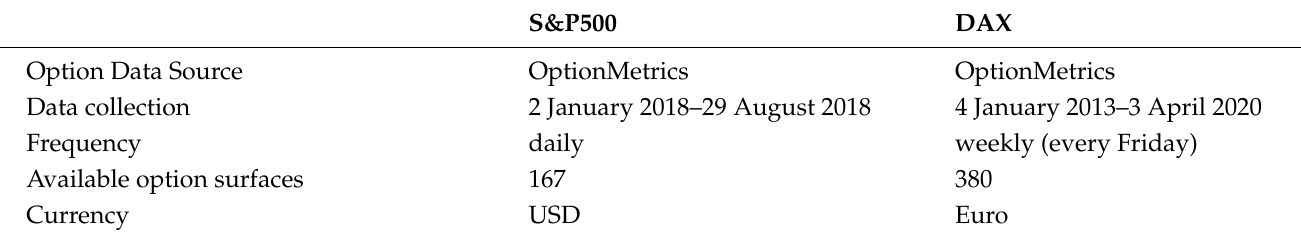
Table 1. Summary of the data features of both the S&P500 and DAX